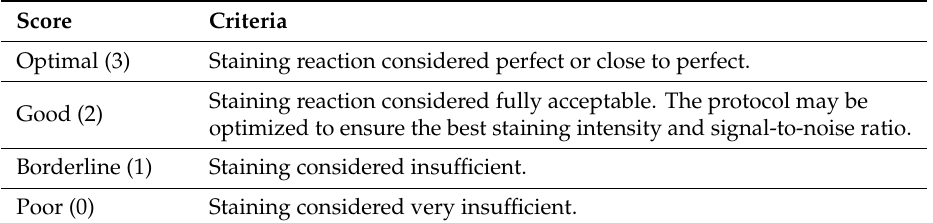
Figure A3 . Antisense peptide Biotin-AVRDKVG applied in high concentration (1:10) produces increase in background, i.e., a non-specific staining of the prostate tissue. Table A2. NordiQC scoring criteria which include staining intensity, signal-to-noise ratio, background staining, aberrant staining pattern, counterstaining and preservation of morphology [57].